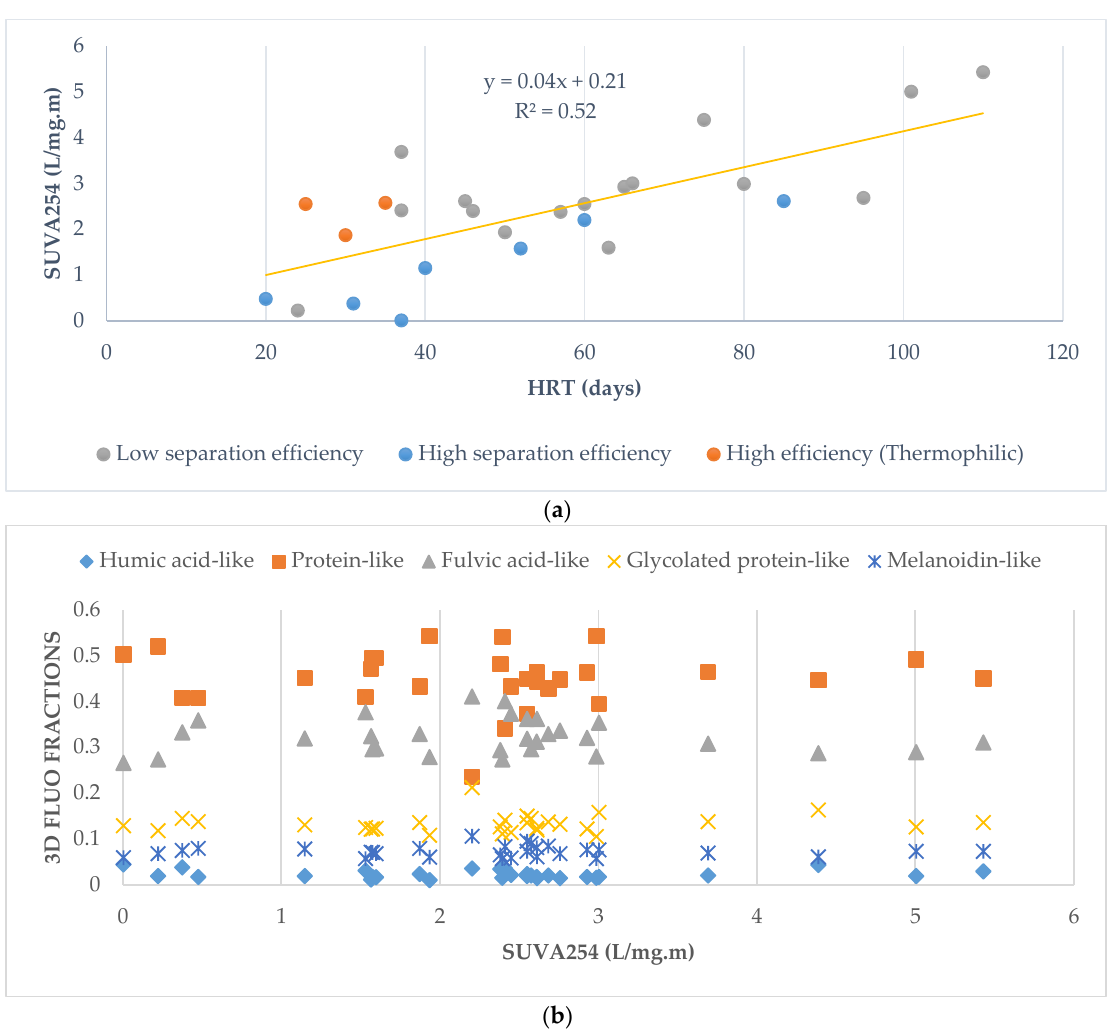
Figure 5. (Left) COD in the liquid fraction vs cow manure percentage and (right) COD in the liquid fraction vs energy Figure 5. ( Left ) COD in the liquid fraction vs cow manure percentage and ( right ) COD in the liquid fraction vs energy crops Energies 2021 , 14 , x FOR PEER REVIEW crops percentage in the feedstock. percentage in the feedstock.